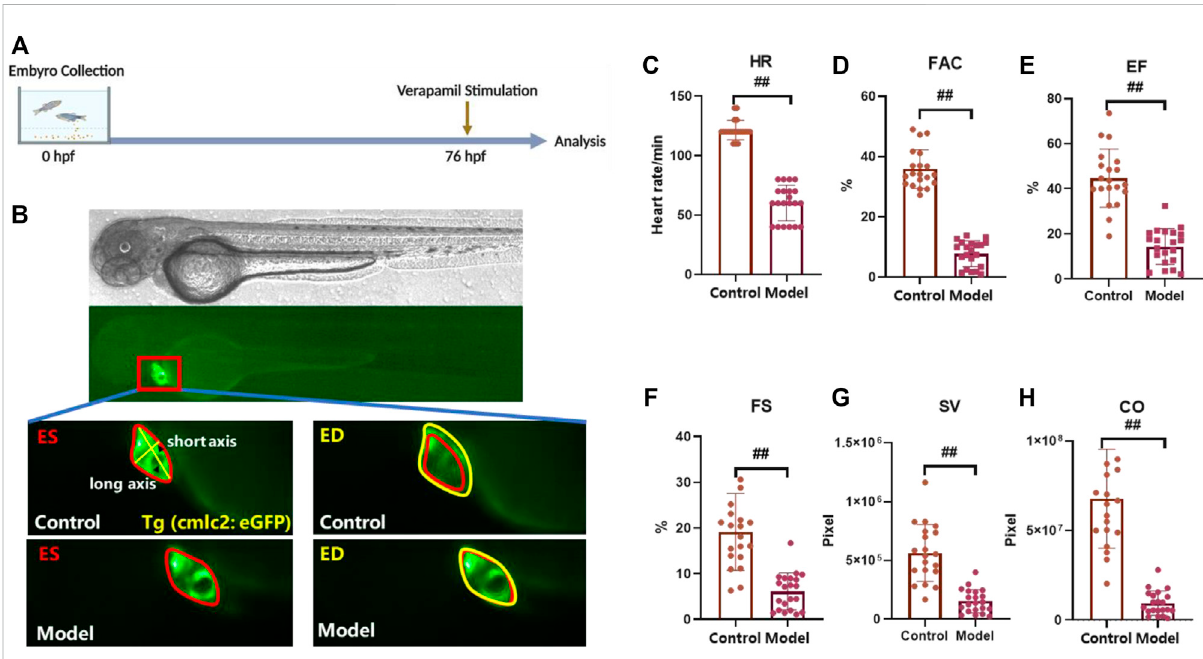
FIGURE 1 Verapamil-induced heart failure model in zebra fi sh (A) Experimental scheme for heart failure model in zebra fi sh. (B) Representative images of vehicle-treated and verapamil-treated zebra fi sh heart. The heart of ES was shown in red line, and the heart of ED was shown in yellow line; ES: end systole, ED: end diastole (C – H) Quanti fi cation of cardiac function in Tg(cmlc2: eGFP) zebra fi sh larvae with verapamil. HR: heart rate, FAC: fractional area change, SV: stroke volume, FS: fractional shortening, EF: ejection fraction, CO: cardiac output. N ≥ 20. # p < 0.05 vs . Control, ## p < 0.01 vs .